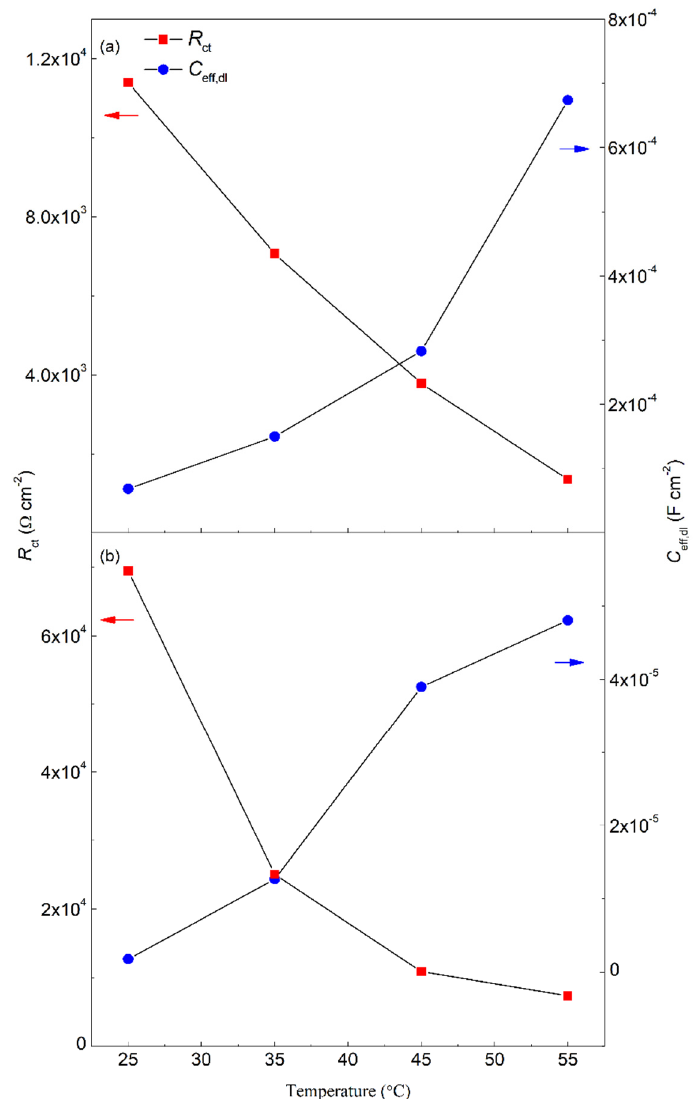
Figure 6. R ct and C eff,dl of carbon steel in ( a ) absence, and ( b ) presence of 0.6 M sodium succinate in 0.6 M Cl − SCPS at 25, 35, 45, and 55 °C.